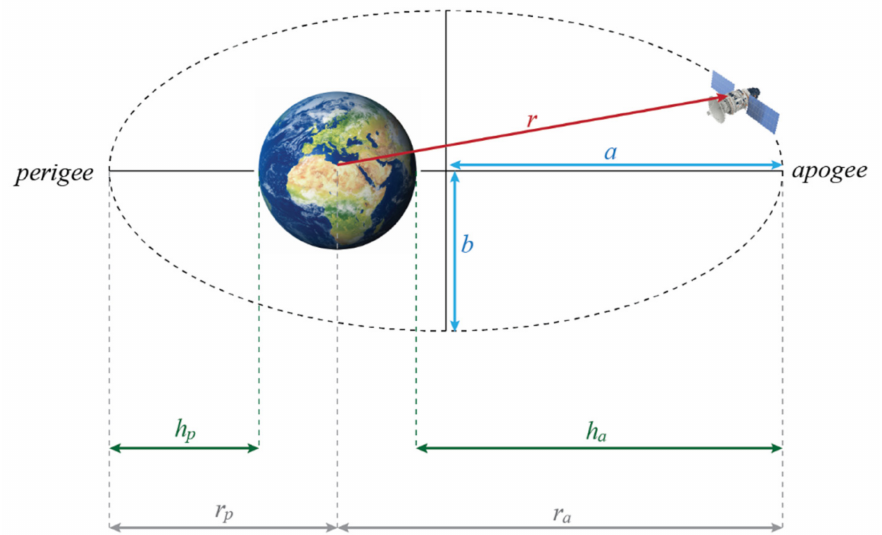
Figure 4. Orbital parameters of an elliptical